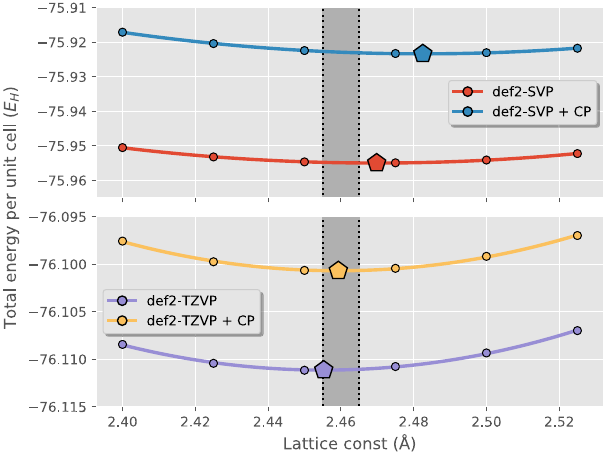
FIG. 10. Uncorrected and CP -corrected total energy of gra- phene for the def2-SVP (top) and def2-TZVP (bottom) basis set for a 8 × 8 supercell calculated with embedded CCSD using η ¼ 10 − 8 . The pentagons denote the equilibrium lattice constants from a quadratic fit of the data points, with the gray stripe showing the experimental uncertainty. Note the significantly different energy scale of the two plots.